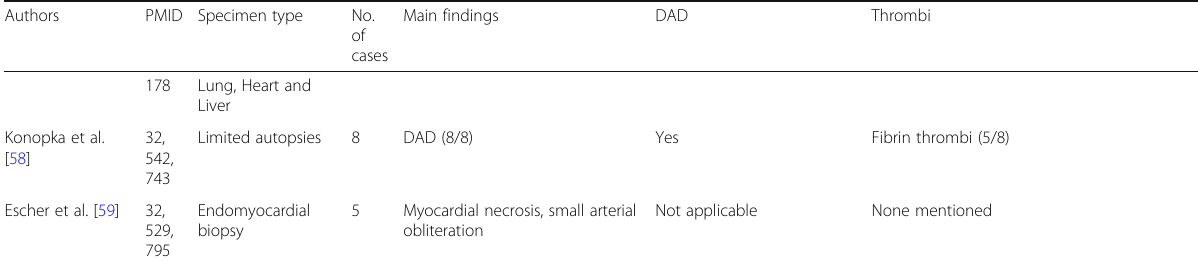
Table 2 Histopathology of COVID-19 (Continued)